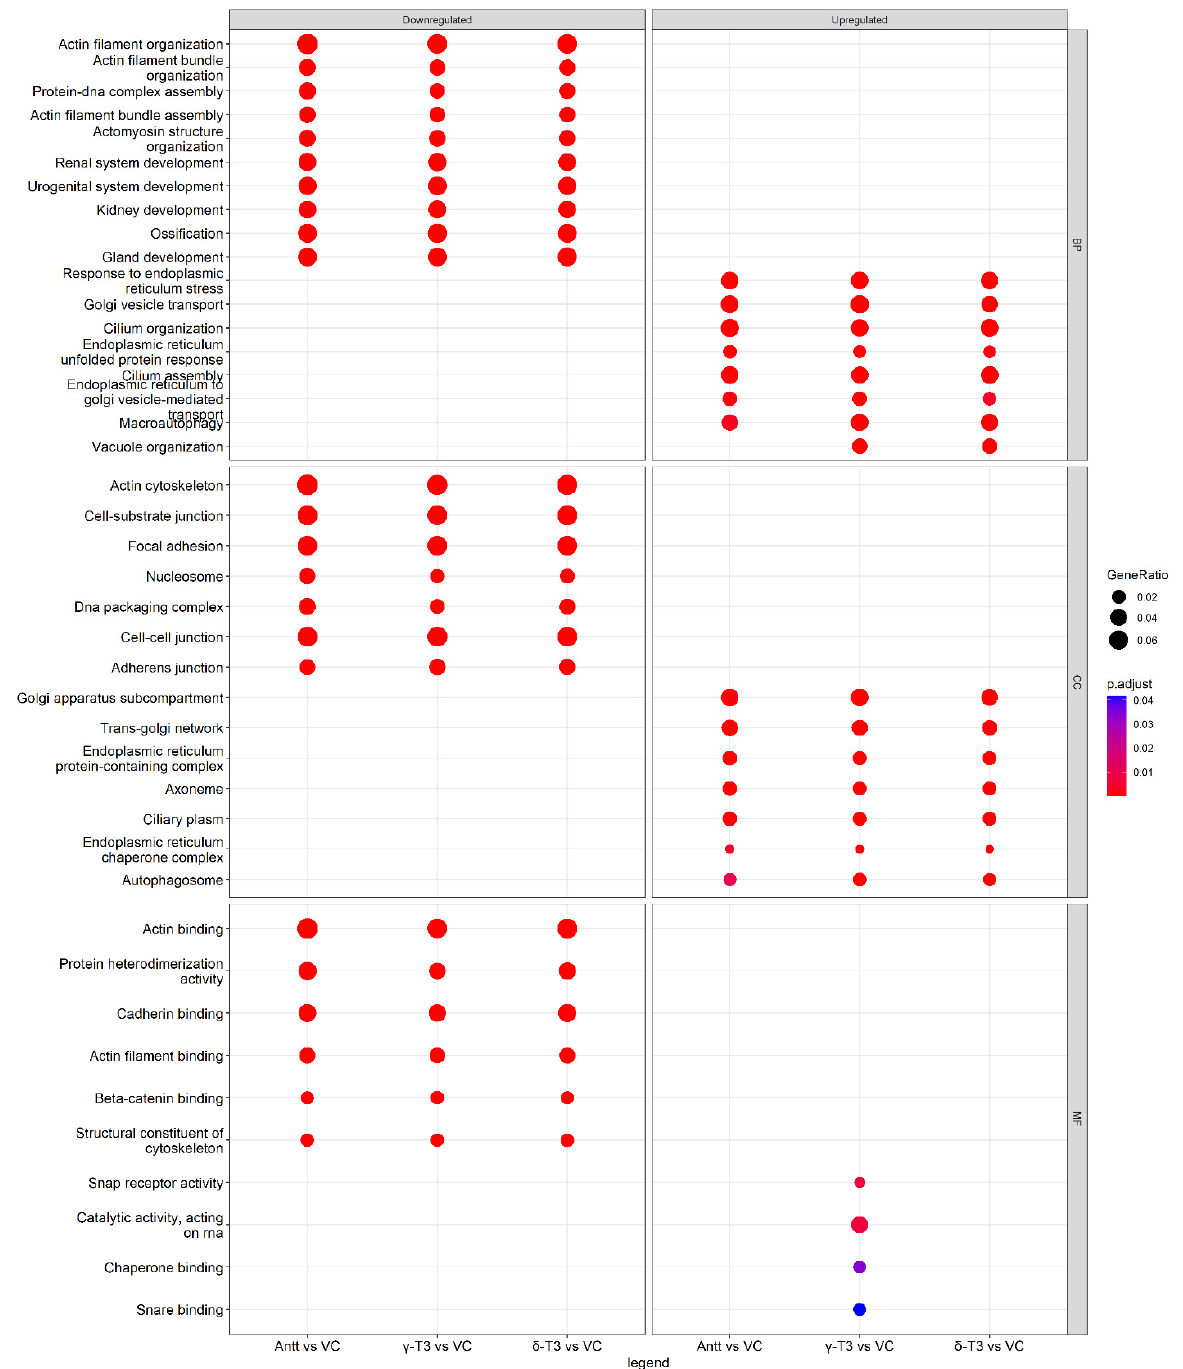
Figure 9. Gene Ontology enrichment of tocotrienol treatments against vehicle control. Pathway enrichment analysis of AnTT versus VC, δ -T3 versus VC, and γ -T3 versus VC, were performed using gene set over-representation analysis using clusterProfiler R package. Abbreviations: BP, biological process; CC, cellular components; MF, molecular function; AnTT, annatto tocotrienol; δ -T3, δ -tocotrienol; γ -T3, γ -tocotrienol; VC, vehicle control.